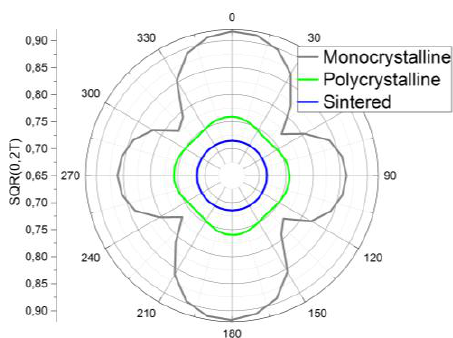
Figure 3. Example of polar plots for monocrystalline, polycrystalline and sintered disks.